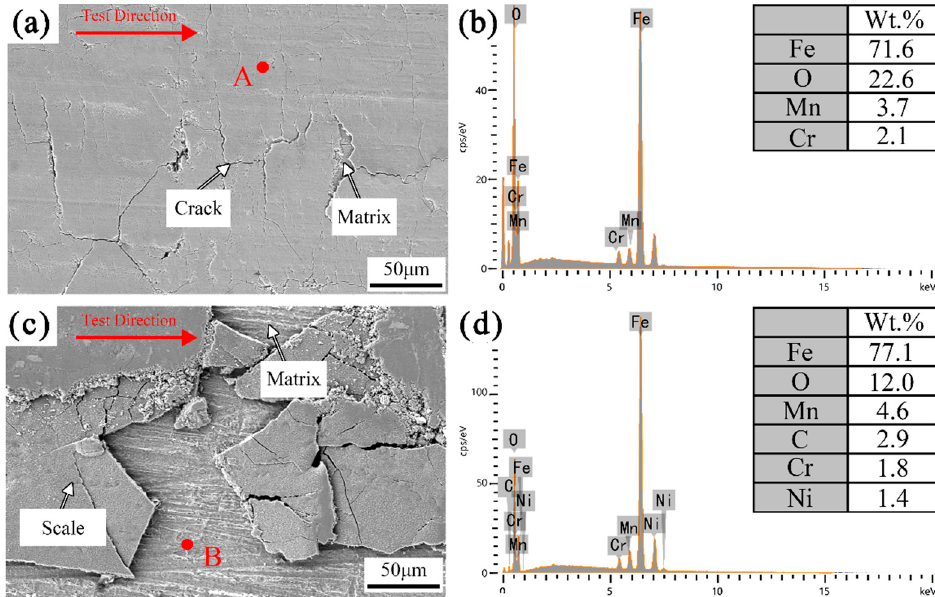
Figure 8. Surface morphology and composition of the sample after friction, ( a ) SEM image of the surface of 10Mn5 steel, ( b ) energy spectrum analysis of 10Mn5 steel (the scale of 10Mn5 steel is mainly composed of Fe and Mn oxides), ( c ) SEM image of the surface of 22MnB5 steel, ( d ) energy spectrum analysis of 22MnB5 steel (the exposed surface of 22MnB5 steel contains both matrix elements and O), where A&B is the point of EDS point analysis.